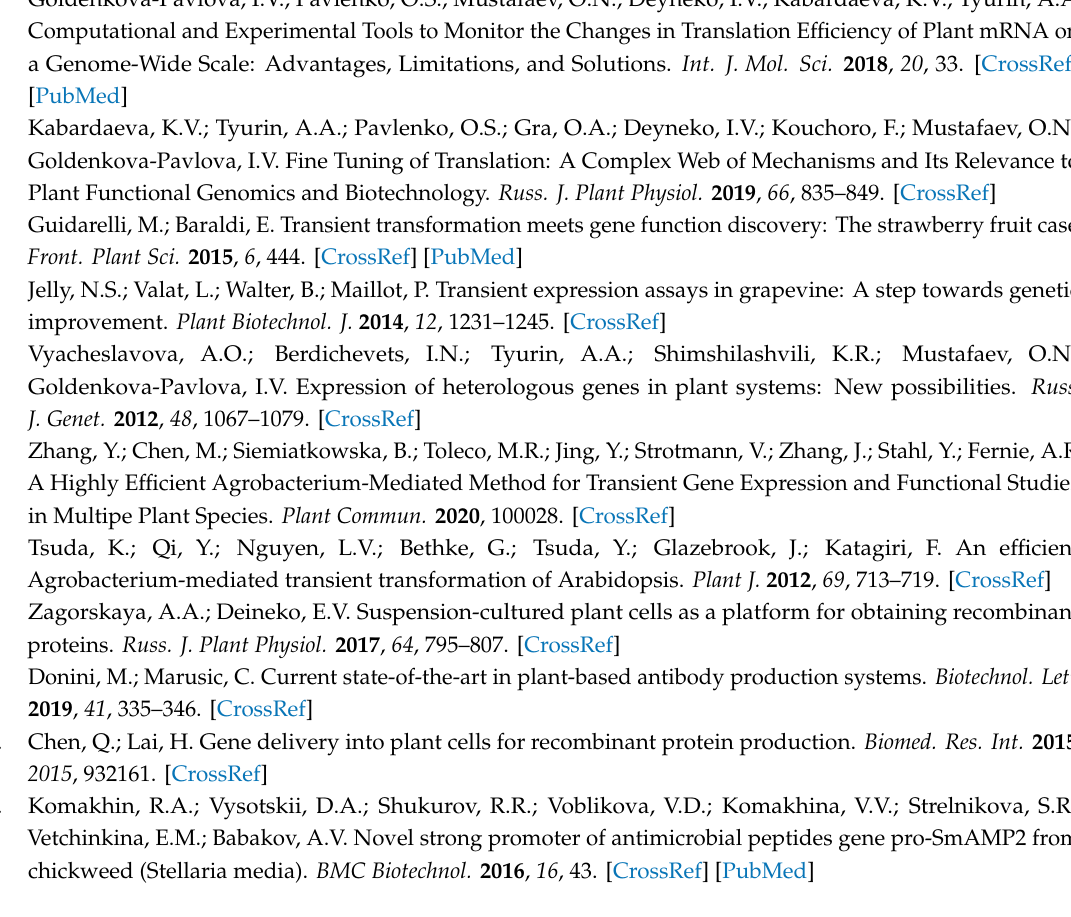
Table S1: Usage of transient expression technology: plant species, experiment goal and Agrobacterium strains (including 429 references), Table S2: Research areas utilizing transient gene expression in plants (including 112